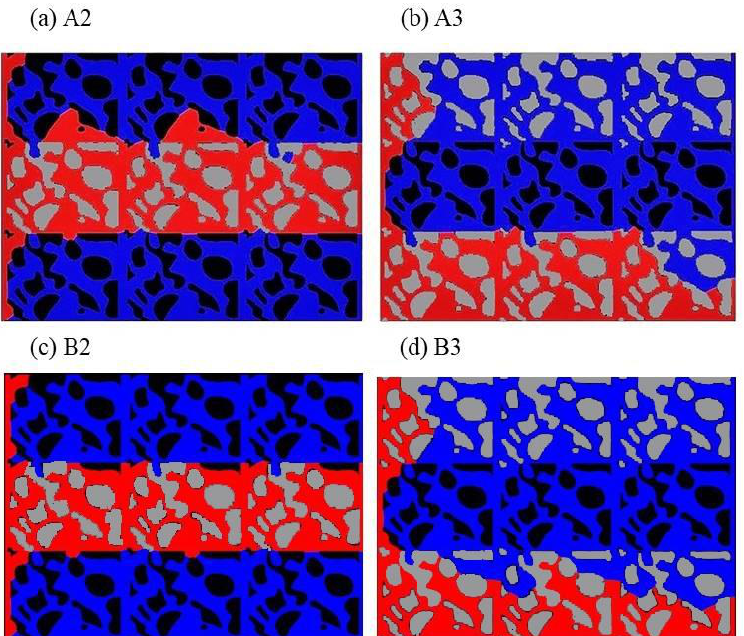
Figure 7. Gas and water distributions (gas-wet solid in gray, water-wet solid in black, and water in blue and gas in red) in porous structures with mixed wettability at the quasi-steady state: ( a ) A2 — continuous gas-wet, 𝑟 𝑔−𝑤 = 1/3; ( b ) A3 — continuous gas-wet, 𝑟 𝑔−𝑤 = 2/3; ( c ) B2 — continuous gas-wet, 𝑟 𝑔−𝑤 = 1/3; ( d ) B3 — continuous gas-wet, 𝑟 𝑔−𝑤 = 2/3.